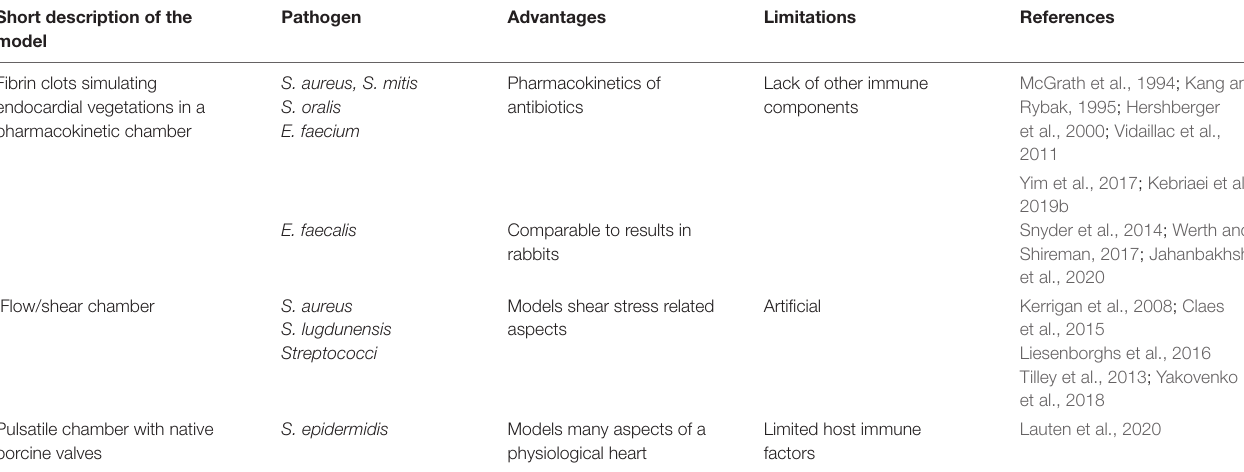
TABLE 2 | In vitro models of infective endocarditis